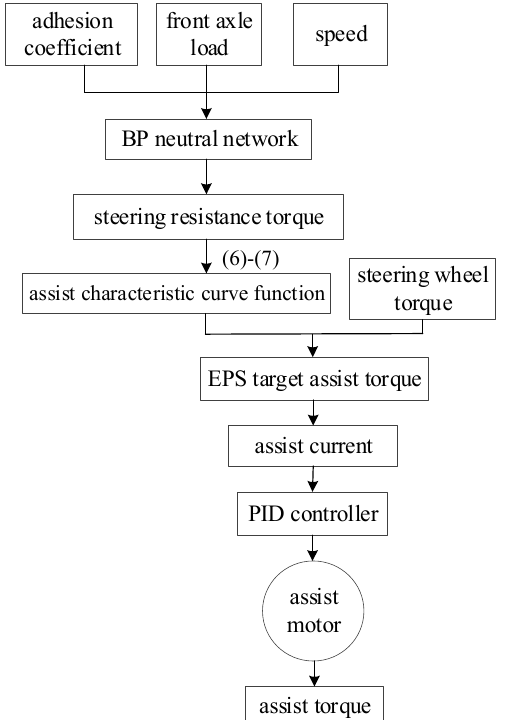
Figure 5. EPS control strategy based on multiple-MAP.